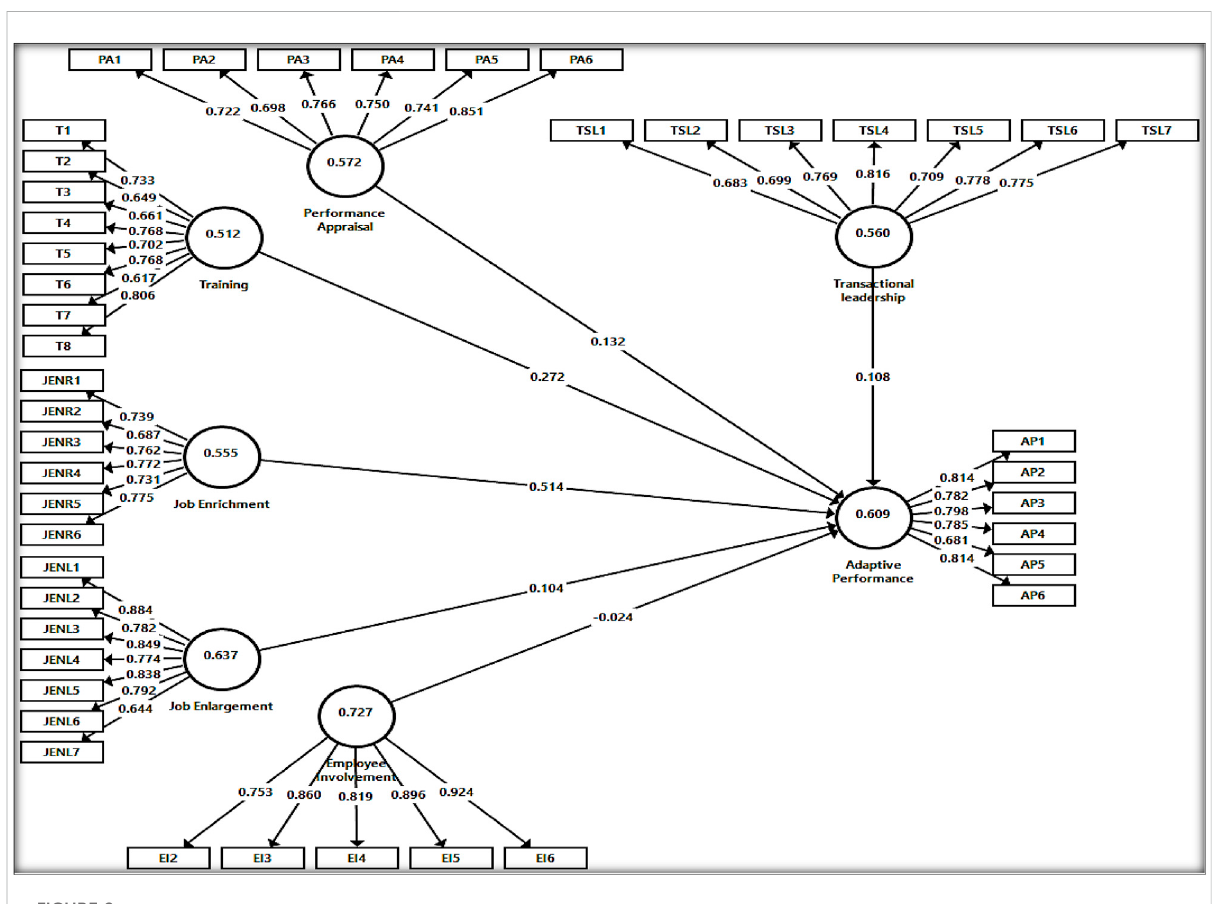
FIGURE 2 Measurement model with factor loadings and AVE values from PLS